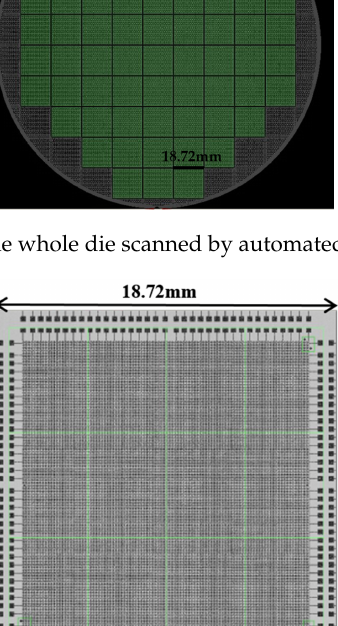
Figure 8. Morphology of a single die scanned by AOI.